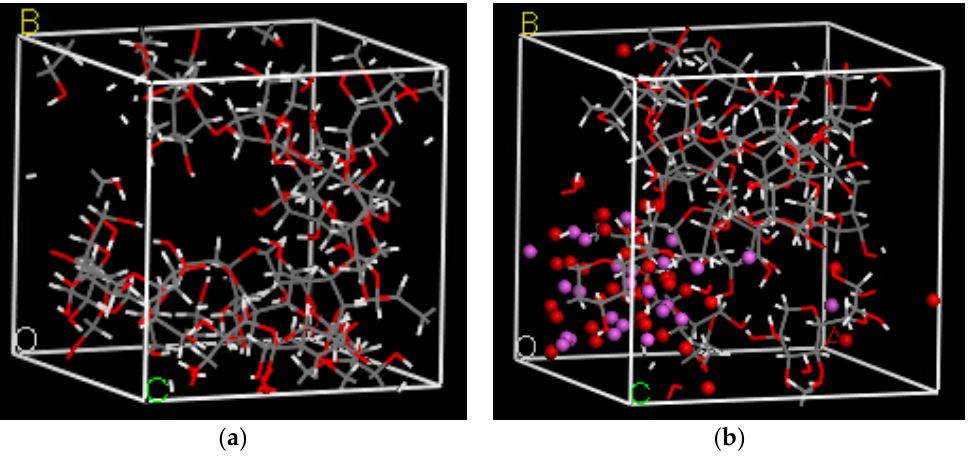
Figure 38. Unmodified cellulose model ( a ) and modified cellulose model ( b ) with addition of nano ‐ AI 2 O 3 [60].